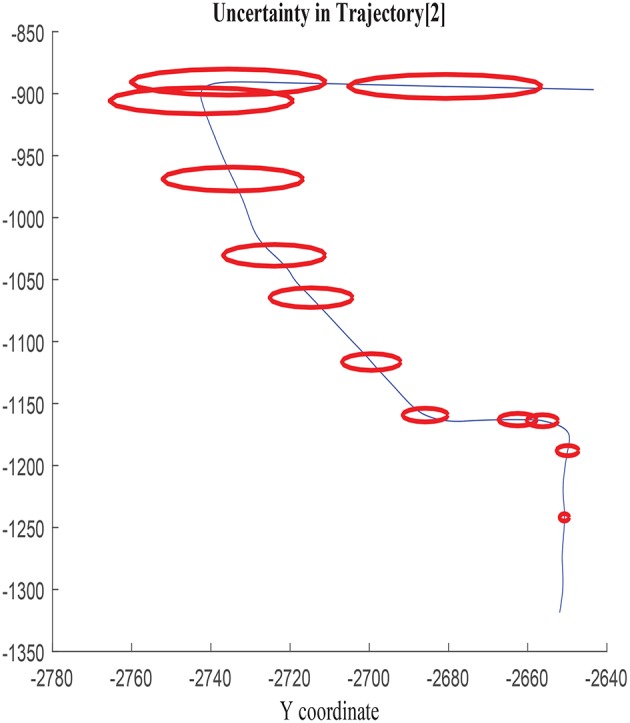
Error ellipses in σx, σy, and covxy in trajectory 2.